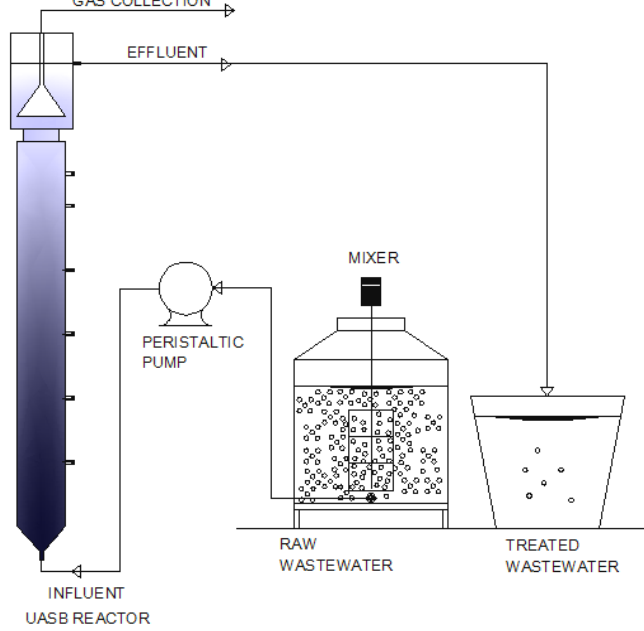
Figure 1. Set up of the filtration experiments in UASB (upflow anaerobic sludge blanket) reactors using wastewater inoculated with Ascaris suum